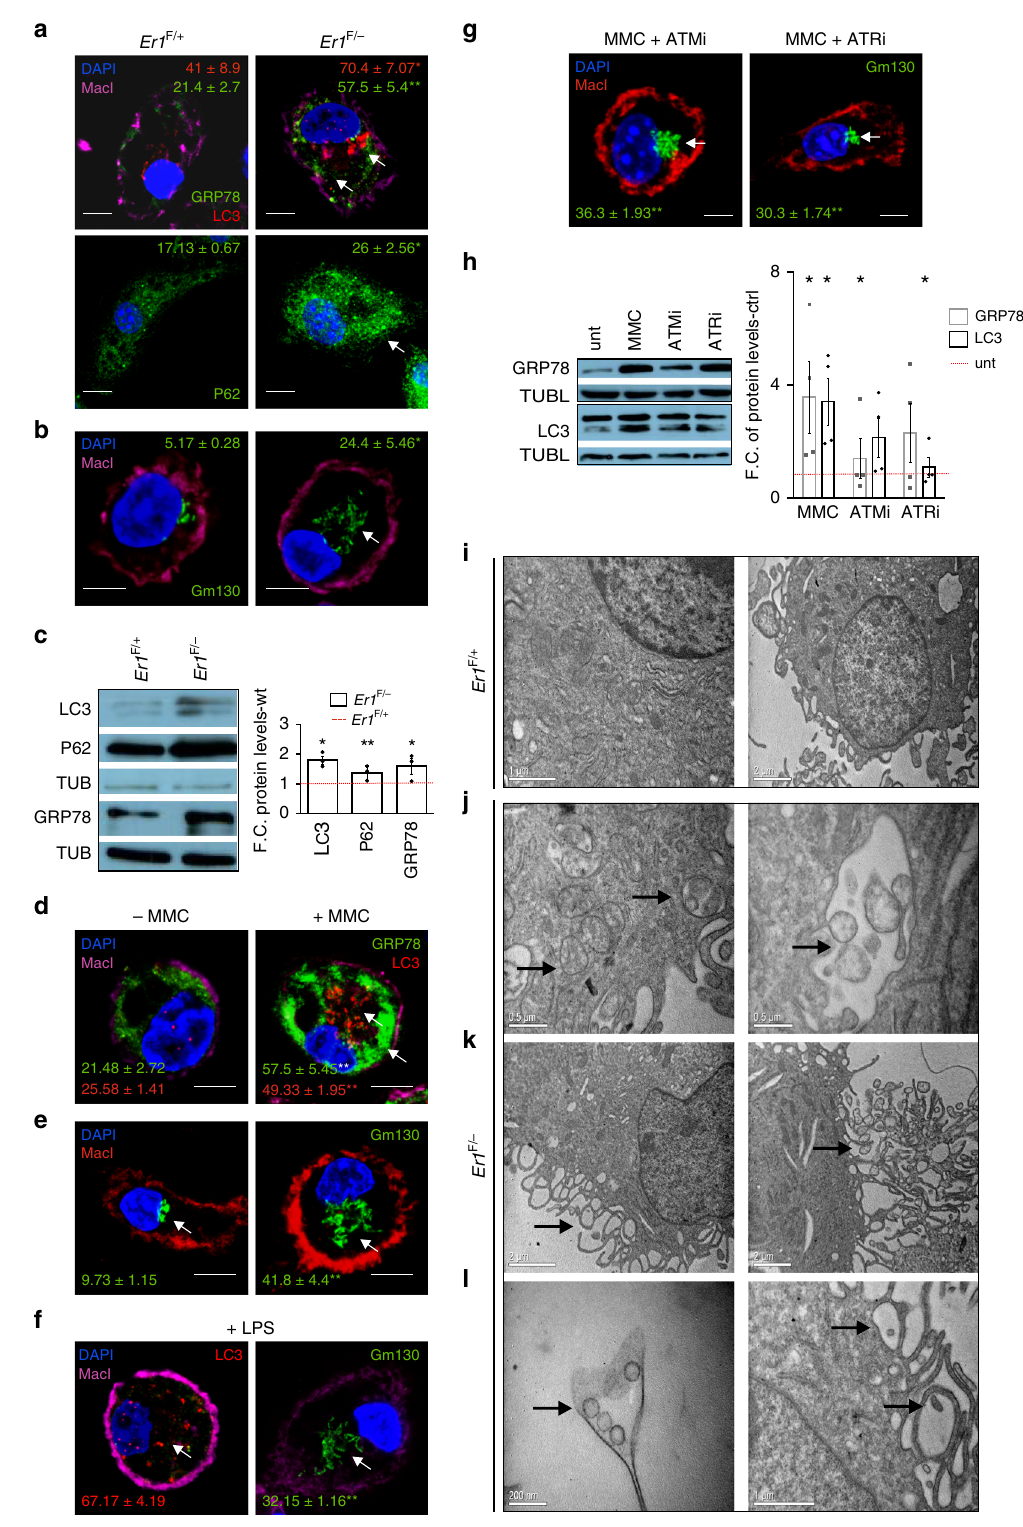
isolated Er1 F/ − and Er1 F/ + macrophage media (Fig. 5a). This strategy led to the identi fi cation of 329 proteins with 211 proteins (64%) being shared by two independent measurements under stringent selection criteria (Fig. 5b and Supplementary data 2 and we fi nd that proteins associated with the presence of (membrane- bound) extracellular vesicles (EVs) and